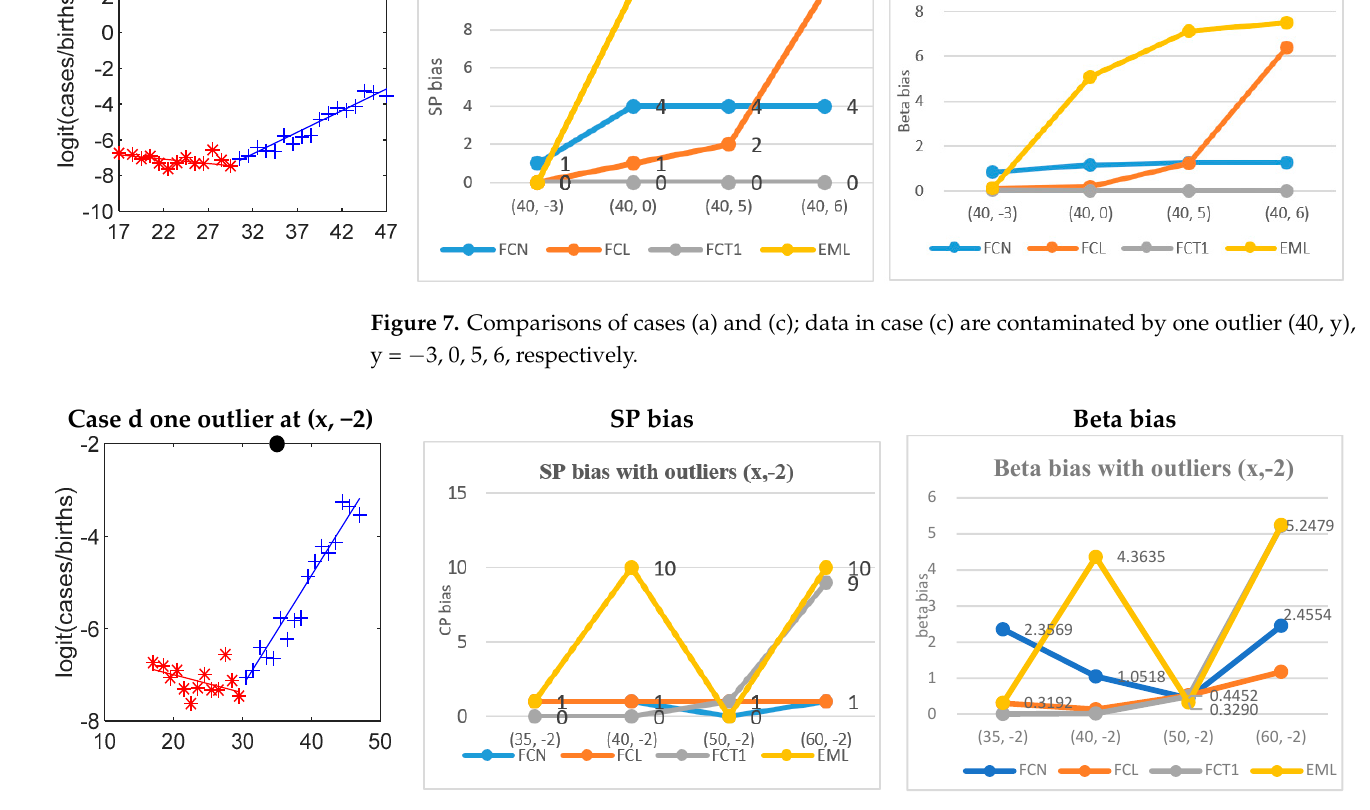
Figure 7. Comparisons of cases (a) and (c); data in case (c) are contaminated by one outlier (40, y), y = − 3, 0, 5, 6, respectively.